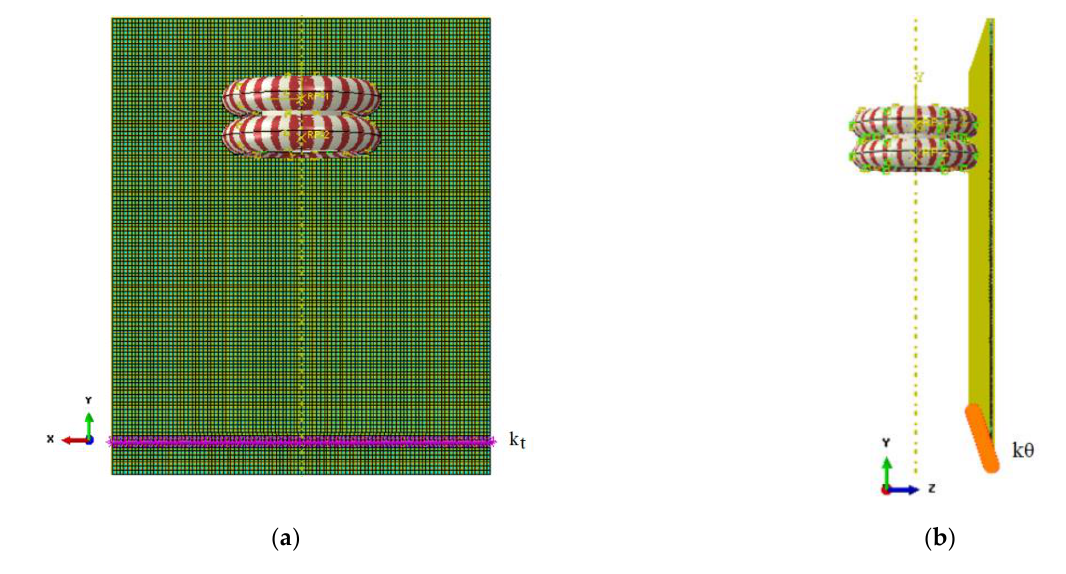
Figure 12. Front and axonometric views of ( a ) SM3 and ( b ) SM4 models under double twin-tyre impact (ABAQUS).